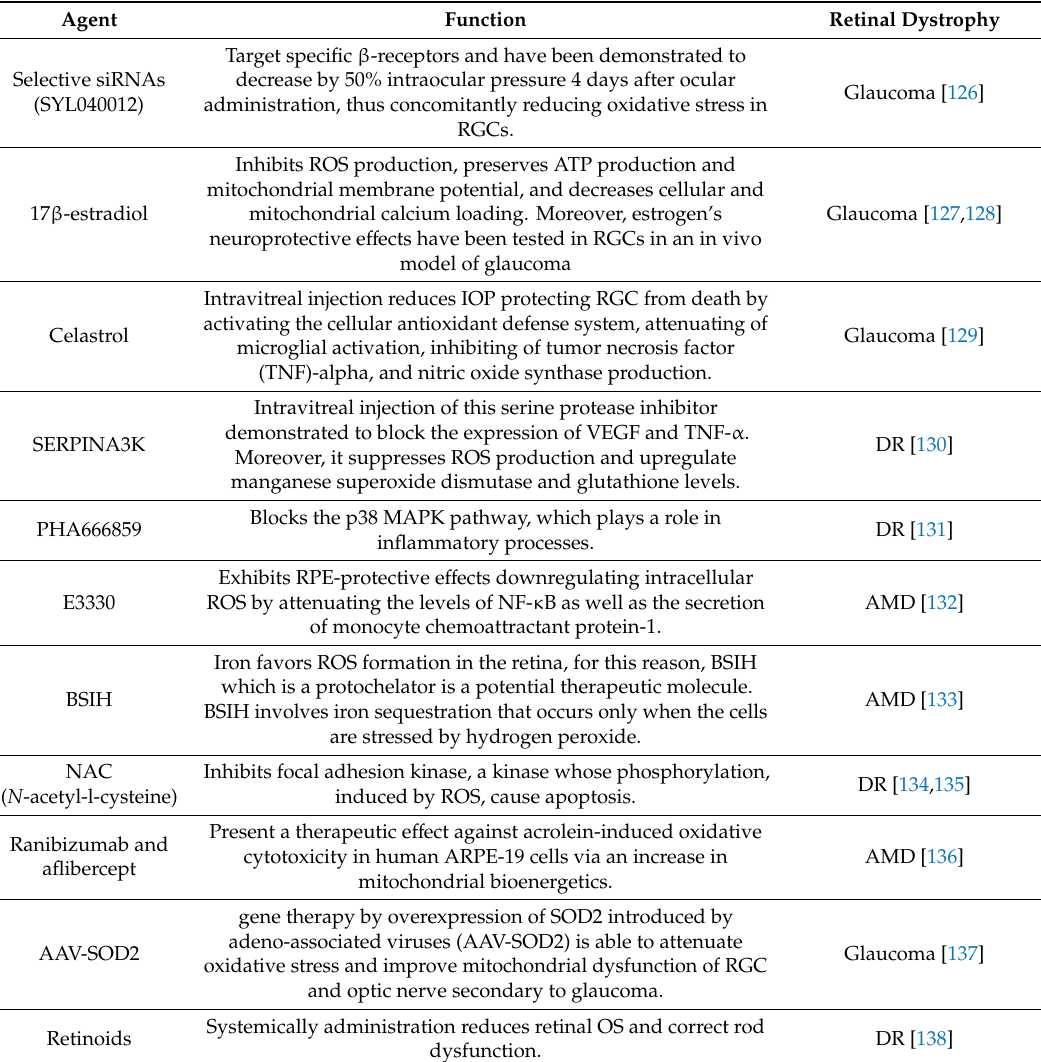
Table 2. Drugs and compounds that reduce reactive oxygen species (ROS) production in retinal cells. Agent Function Retinal Dystrophy Selective siRNAs